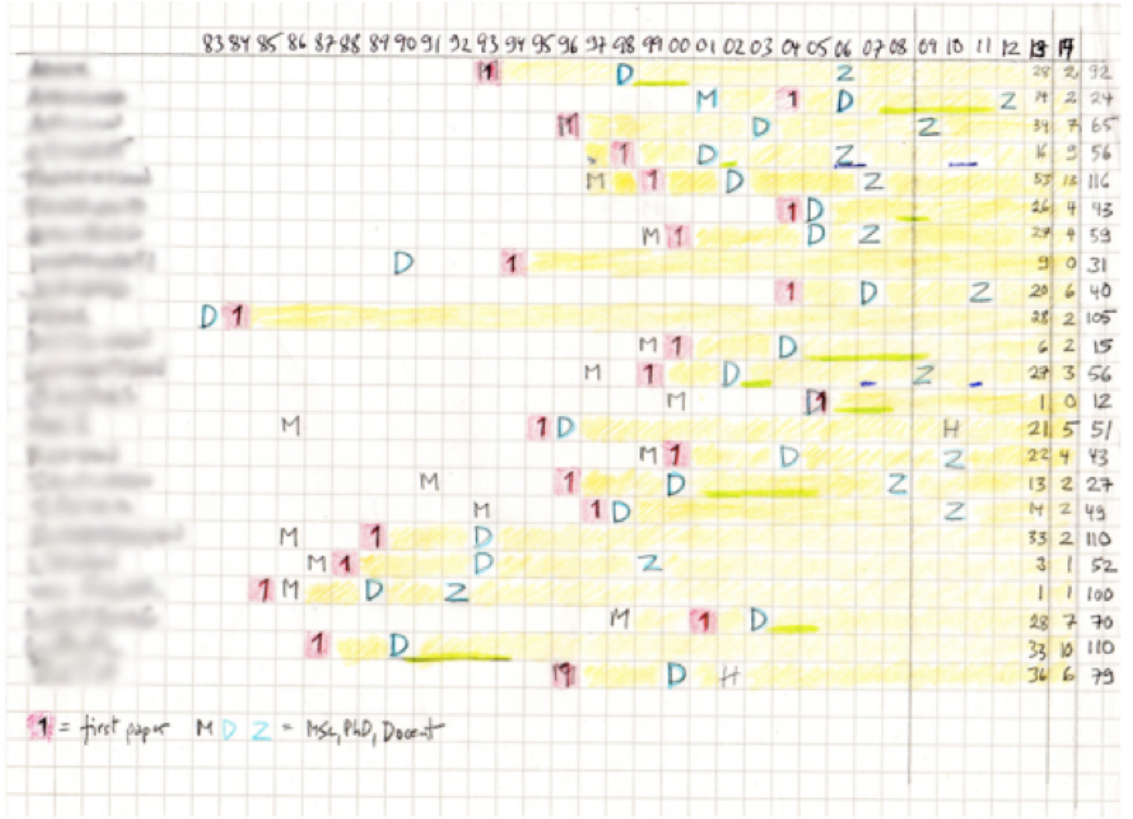
Figure 3 Picture of illustration titled ‘A schematic view of applicants’ careers in science’ (anonymized) Source: Bio UU 2014–1: